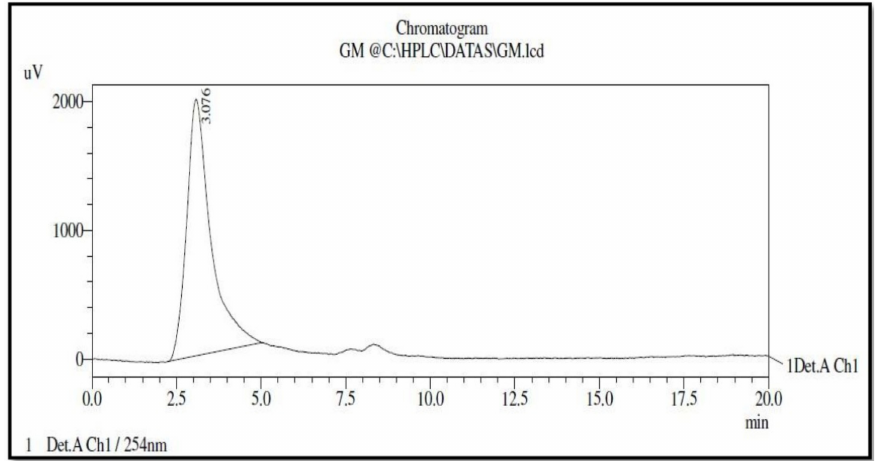
Figure 3. HPLC analysis of purified compound from Fulvifomes